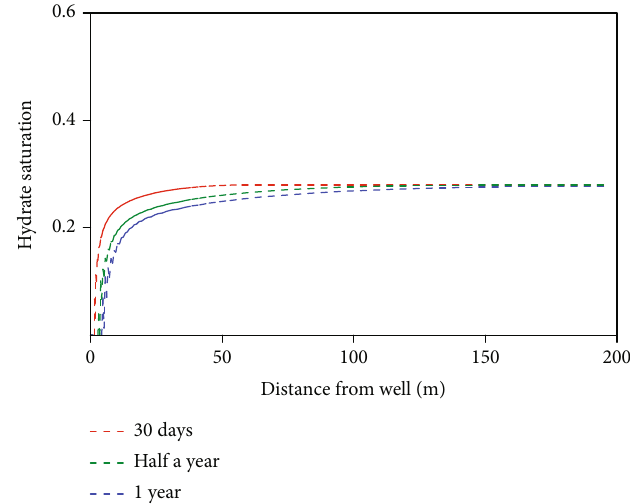
Figure 14: The distributions of hydrate saturation at di ff erent